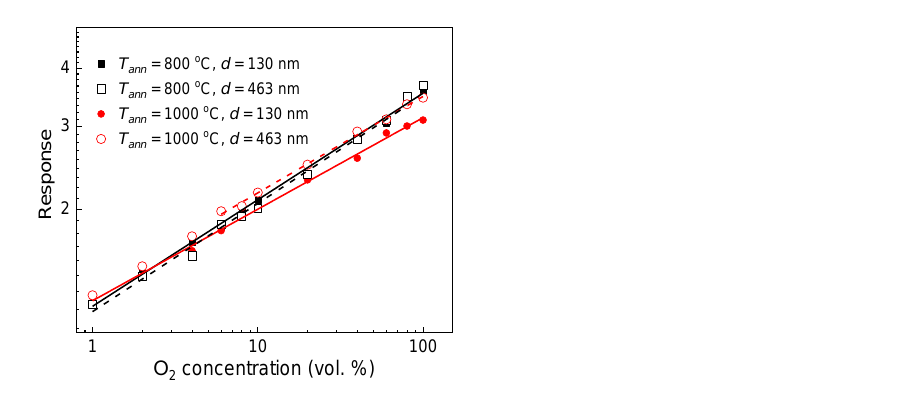
Figure 6. Dependences of the response on the O 2 concentration at T oper = 750 °C. Table 4. Power indexes l for TiO 2 thin films at T oper = 750 °C.